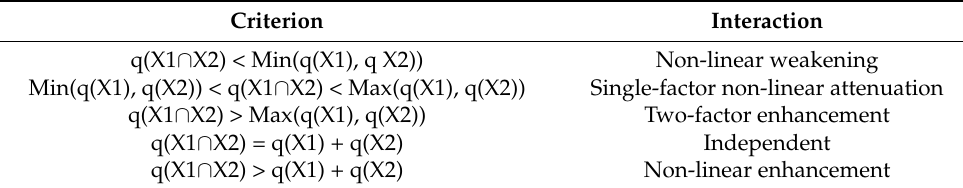
Table 3. Interaction relationship.